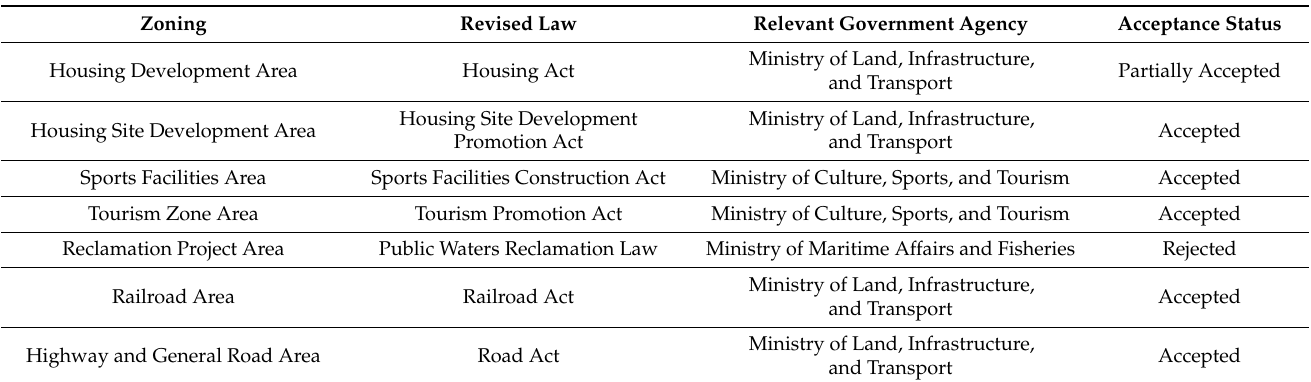
Table 2. Results of government opinion inquiry on law revision to make legal fiction mandatory in digital cadastral map preparation. Source: Ministry of Land Infrastructure and Transport